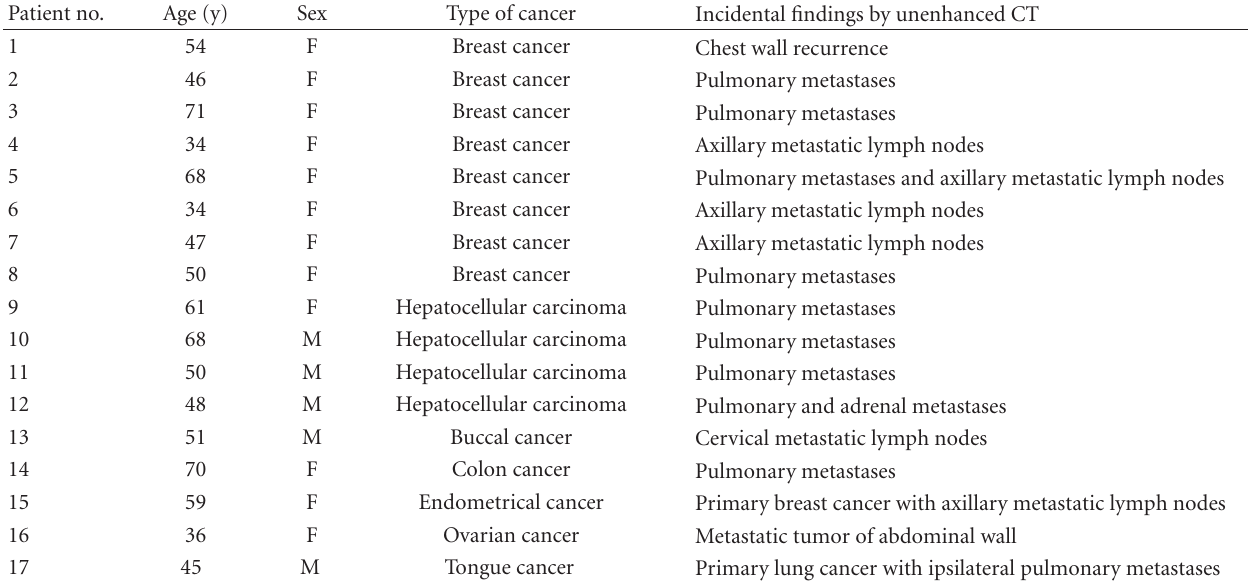
Table 1: Clinically significant extraosseous findings on CT of 18 F-fluoride PET/CT. Patient no.